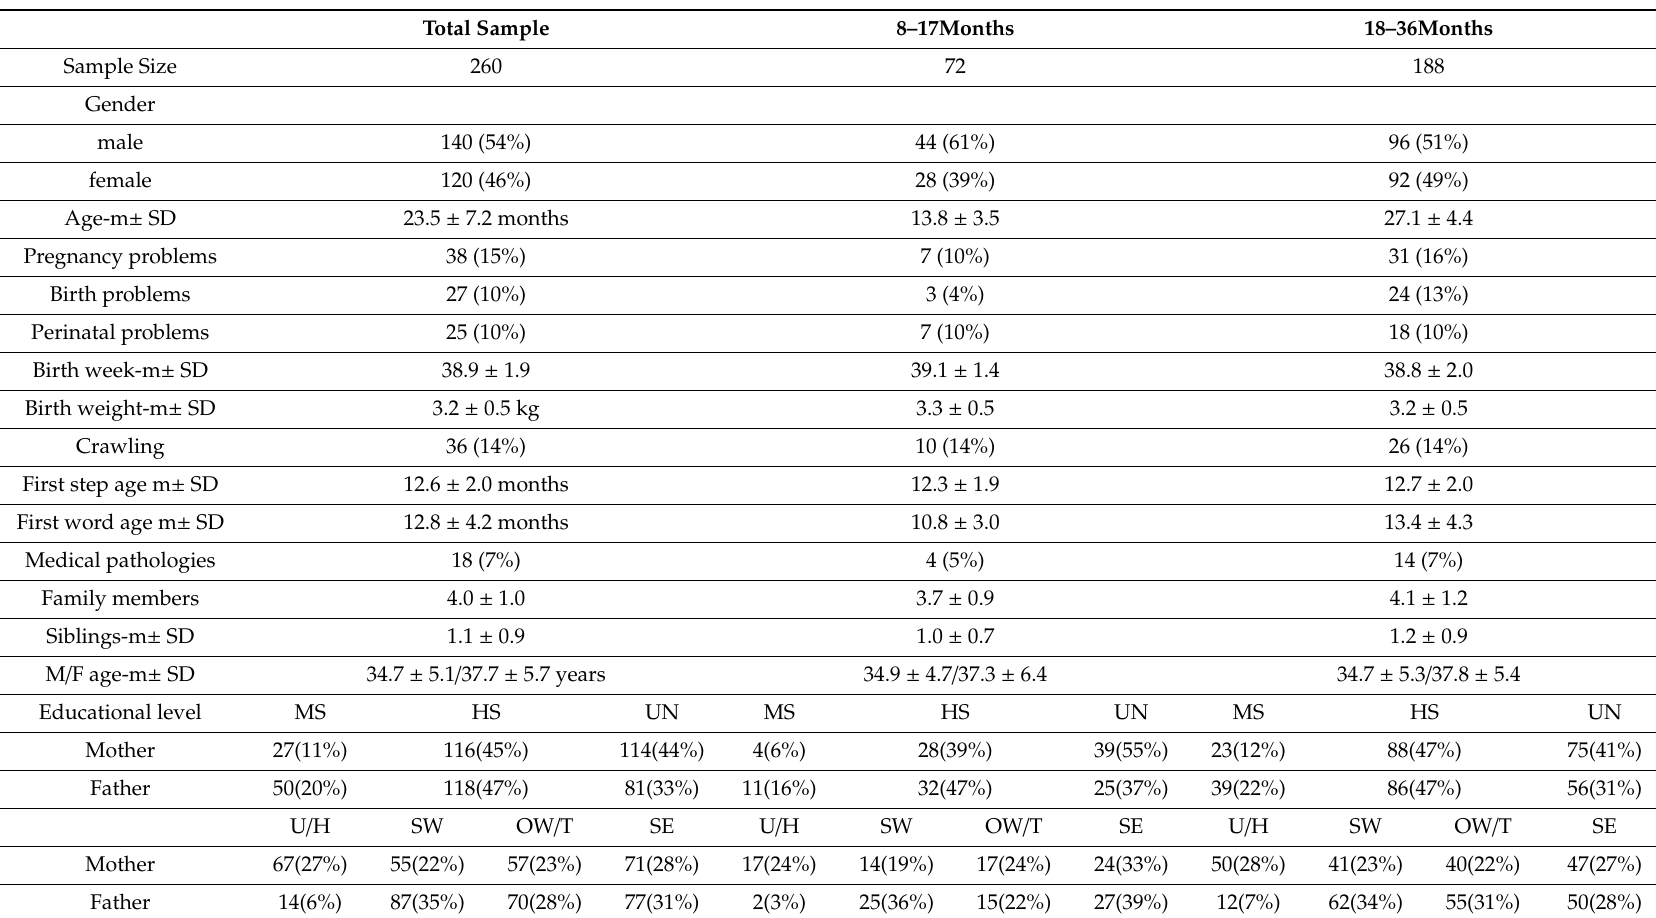
Table 1. Sample characteristics. m = mean; SD = standard deviation; M = mother; F = father; MS = middle school; HS = high school; UN =